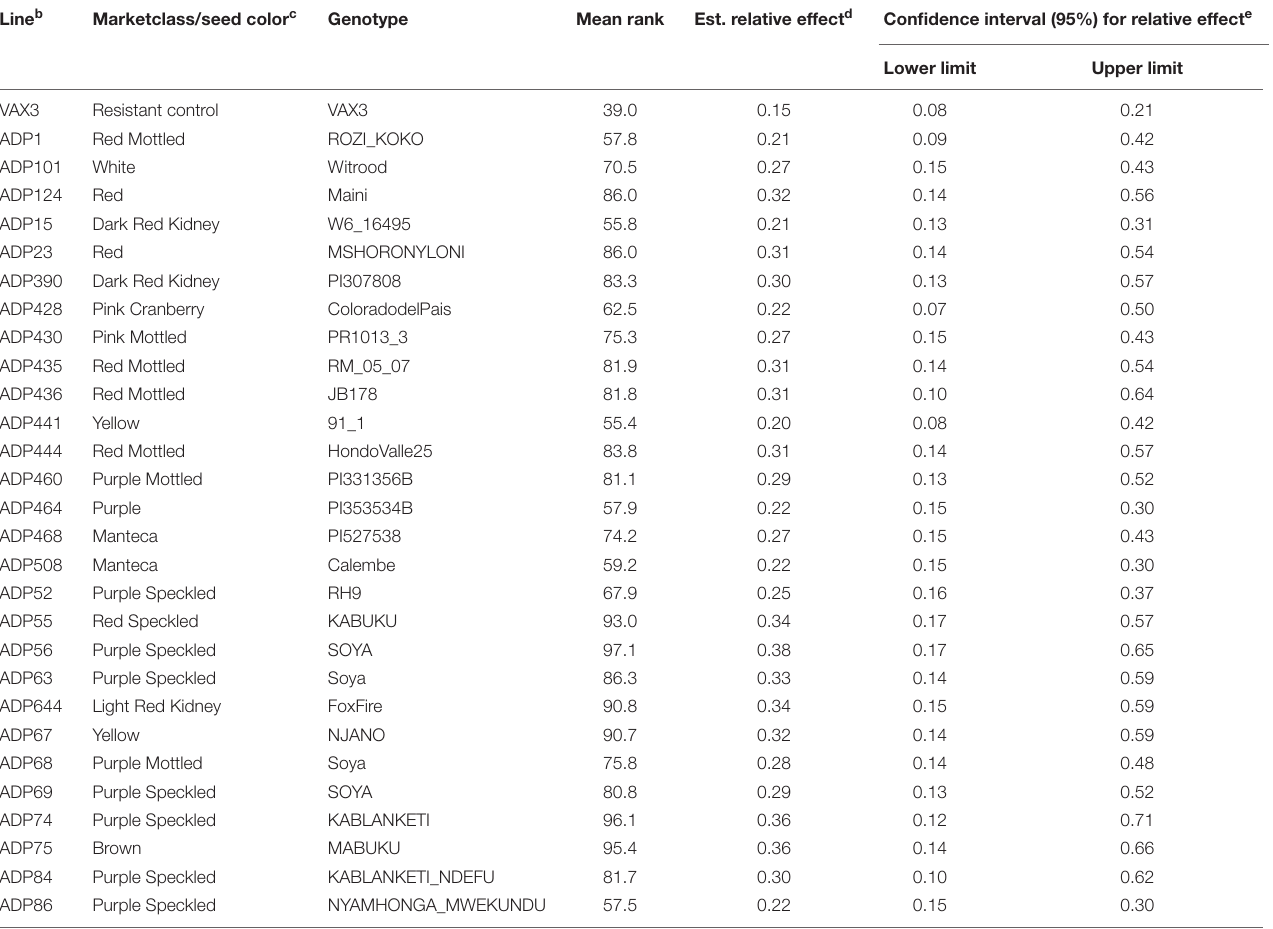
TABLE 2 | Summary of phenotypic data for common bean genotypes within the Andean Diversity Panel (ADP) statistically similar to the resistant control VAX3. Overlapping confidence intervals and p- values ( α < 0.05) a were used to determine statistical similarity between bean lines and the resistant control